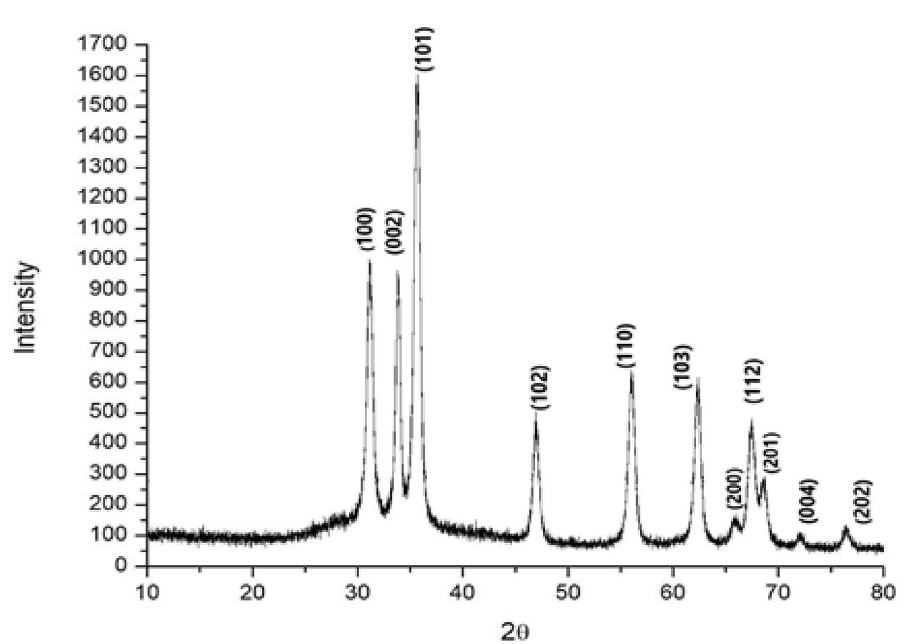
Figure 7. X-ray diffraction pattern of ZnO nanoparticles synthesized by Al. sp. W7 supernatant. All peaks indicate purity and crystalline nature. No traces of other impurity phases were